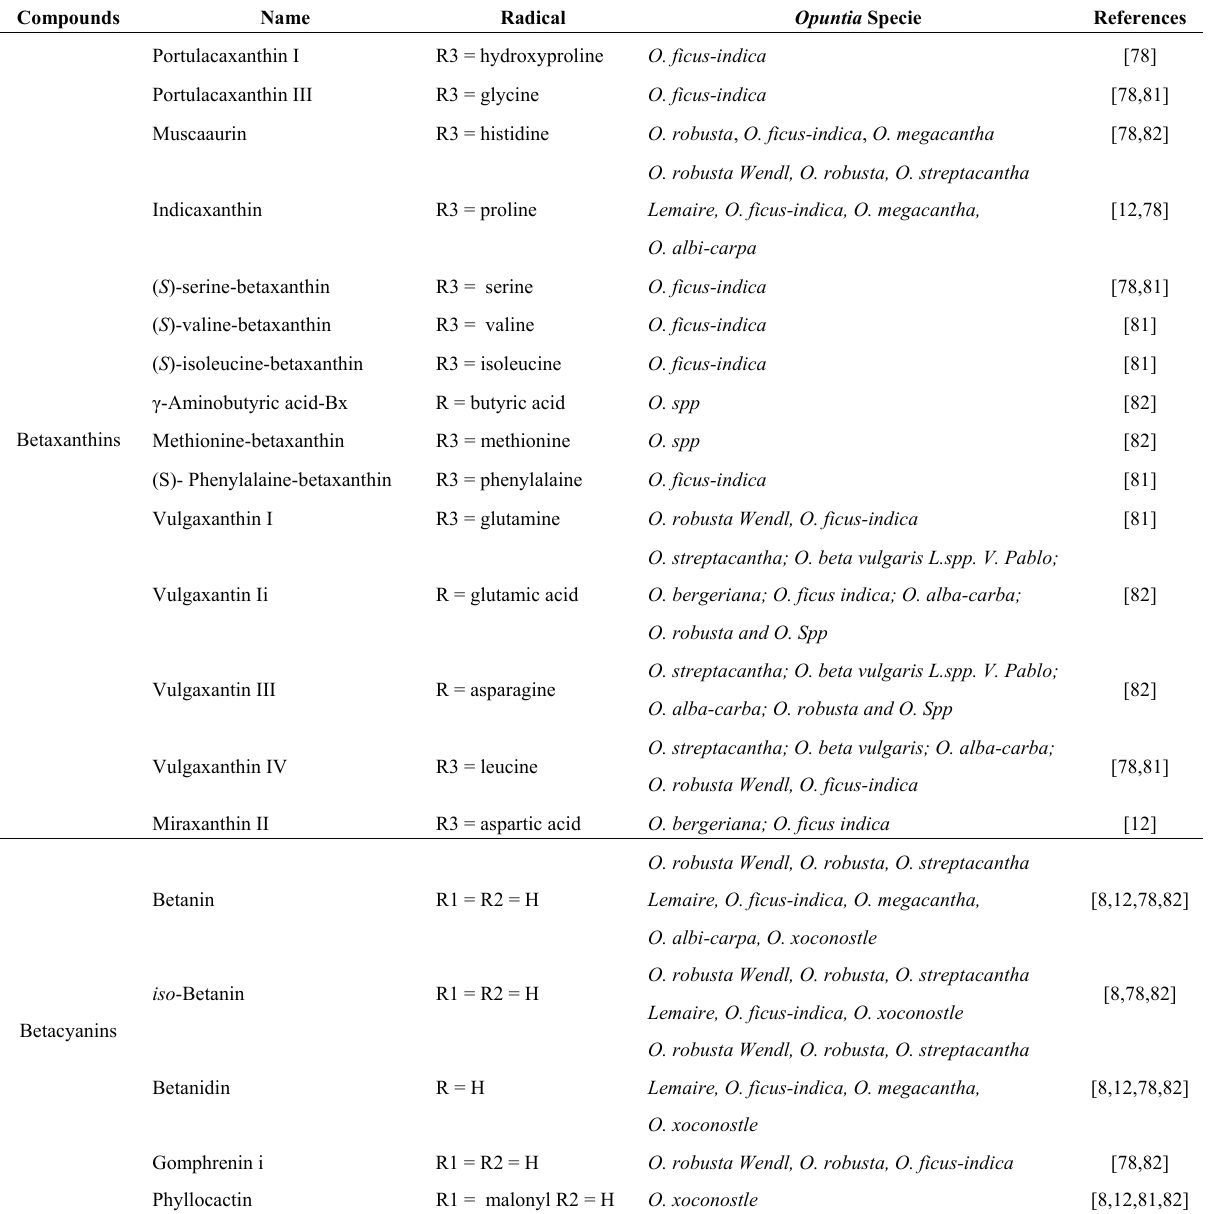
Table 7. Names of betaxanthins and betacyanins present in Opuntia spp .